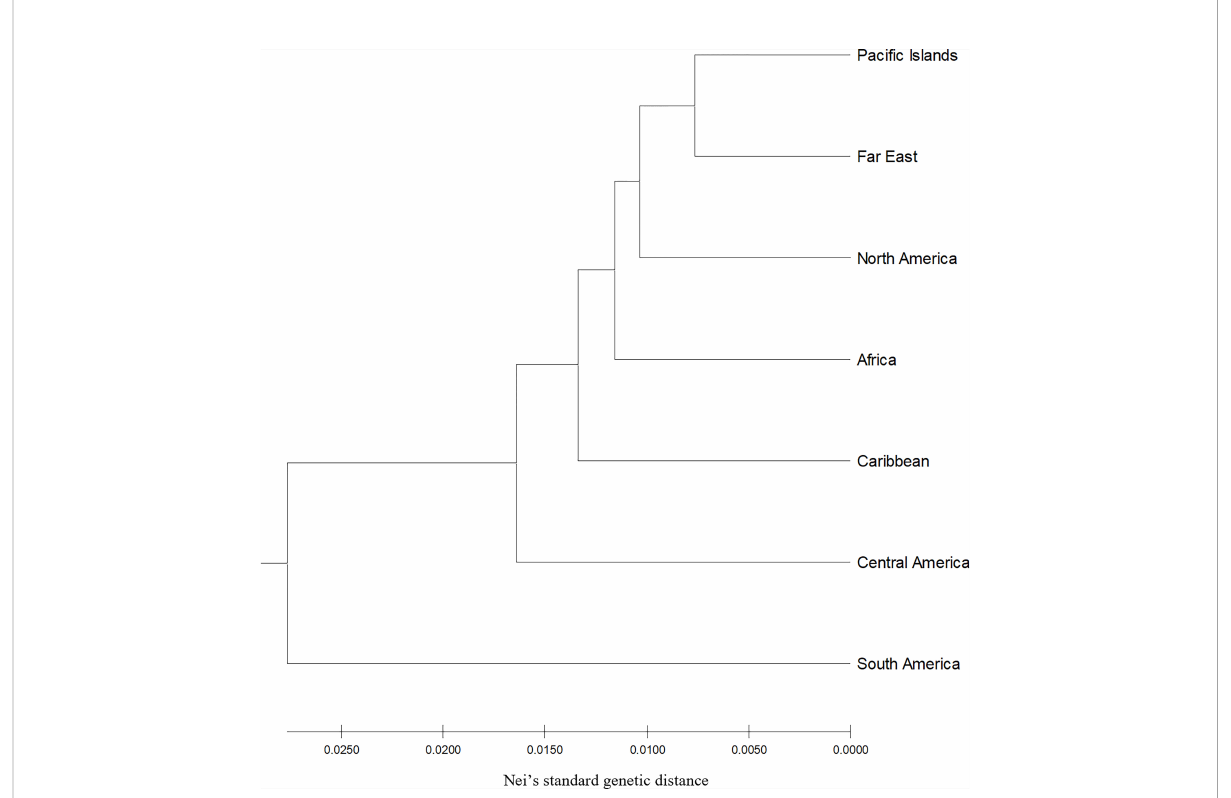
FIGURE 1 Hierarchical clustering unweighted pair group method with arithmetic mean by geographic region using Nei ’ s standard genetic distance of 604 sweetpotato ( Ipomoea batatas )